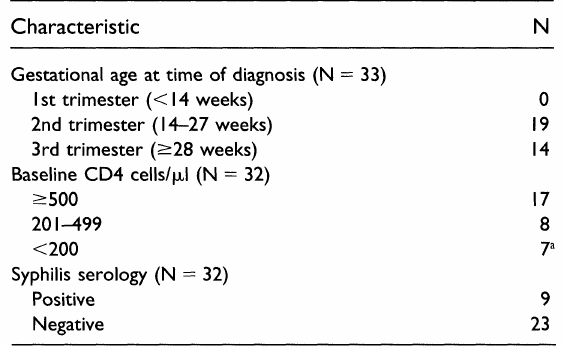
TABLE I. Selective clinical characteristics of newly identified HIV-positive pregnant